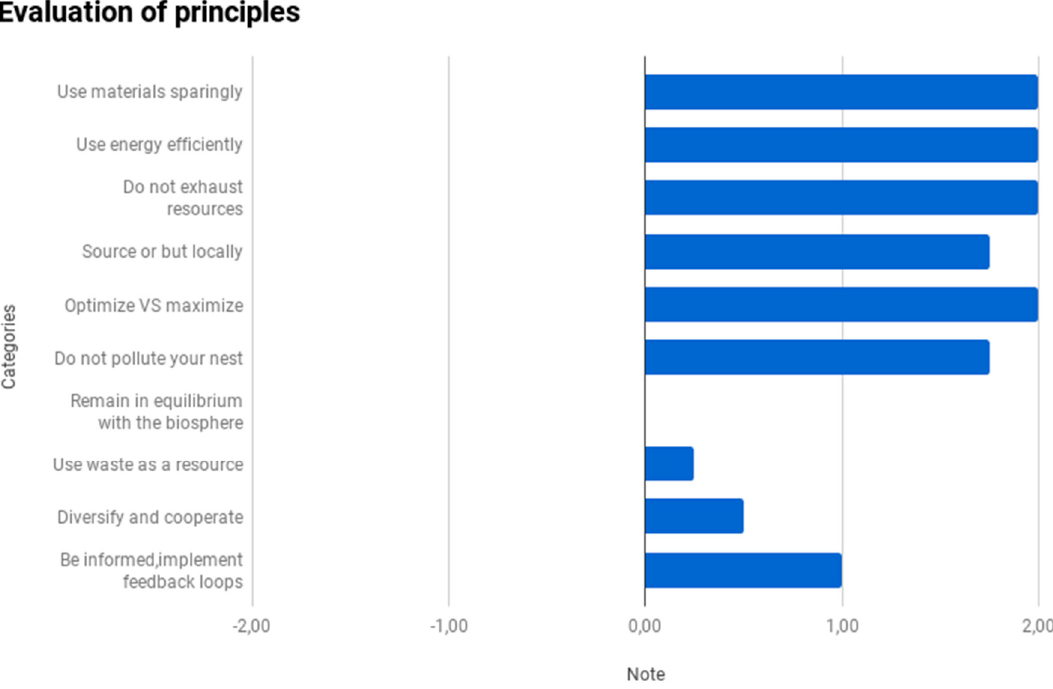
Figure 5. Average value of the notes to questions for each principle. Dashboard of the qualitative results given by results given by BiomiMETRIC.